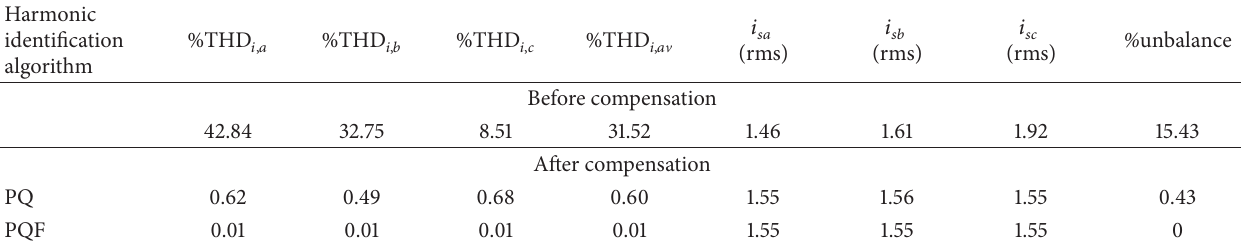
Table 3: The performance comparison between the PQ and PQF algorithms for unbalanced